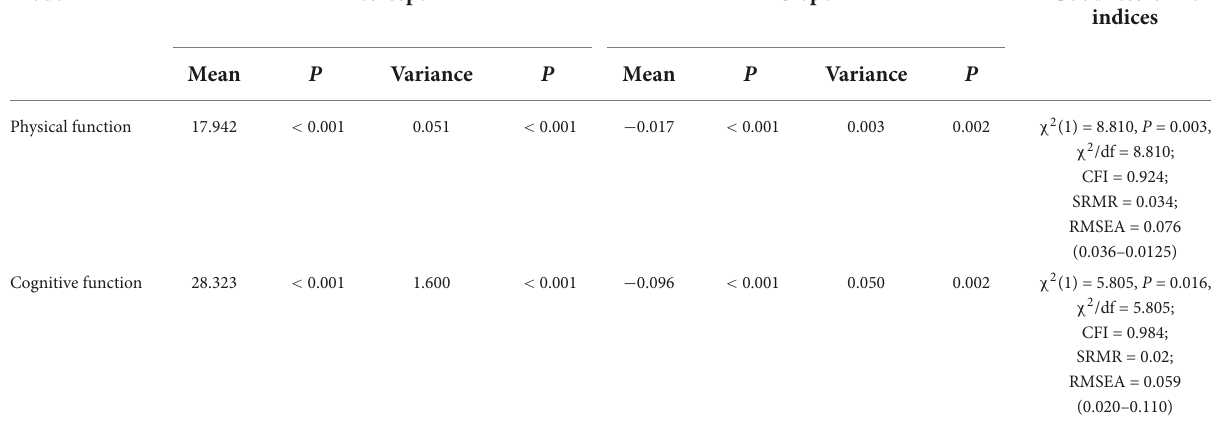
TABLE 2 Results of univariate latent growth model analyses.